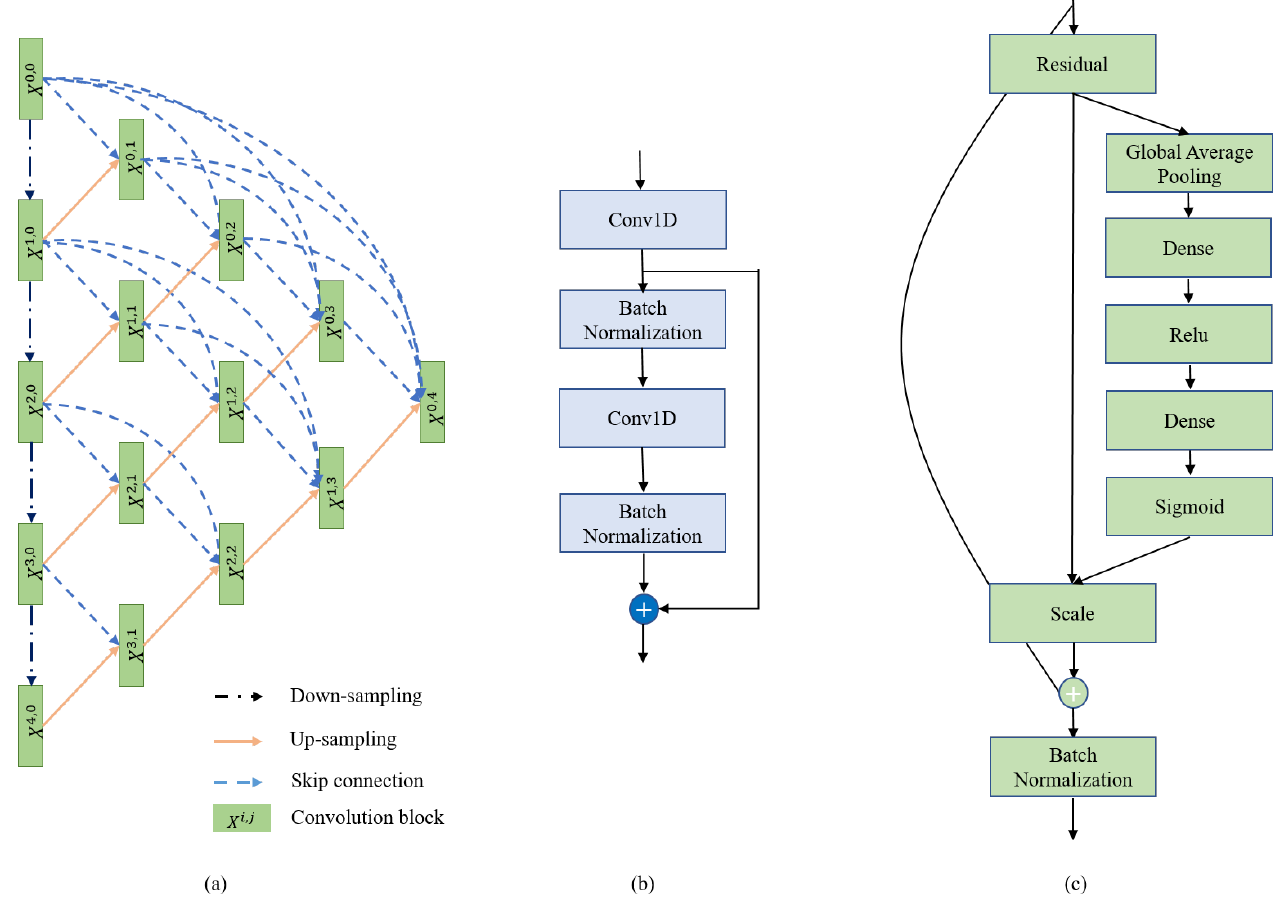
Figure 3. Structure of ( a ) the overall UNet++ network structure, ( b ) residual module and ( c ) convolution